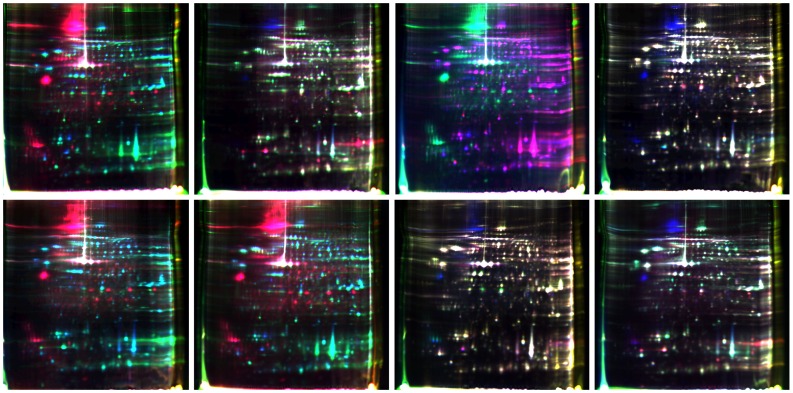
2D-DIGE gels illustrating proteins of five developmental stages of A.C.In standard conditions, internal control samples containing the proteins of mixture of 5 equal protein samples labeled with Cy2 (blue). Cy3 (green) and Cy5 (red) were alternated. Color picture was the overlapping images.